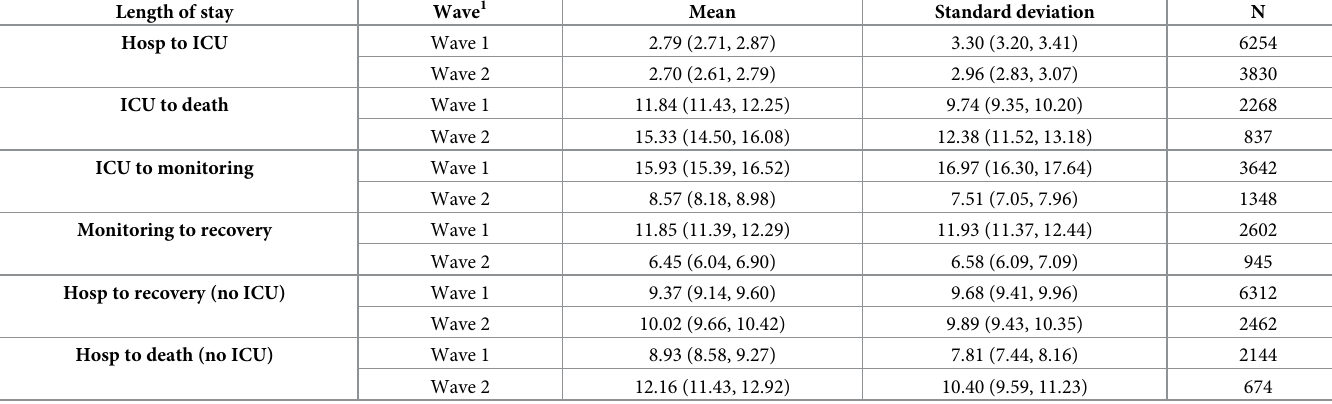
Table 1. Gamma distributed length of stay for different events in hospital, estimated using the CHESS/SARI data. Brackets indicate 95% confidence intervals (gener- ated through parametric bootstrapping). Length of